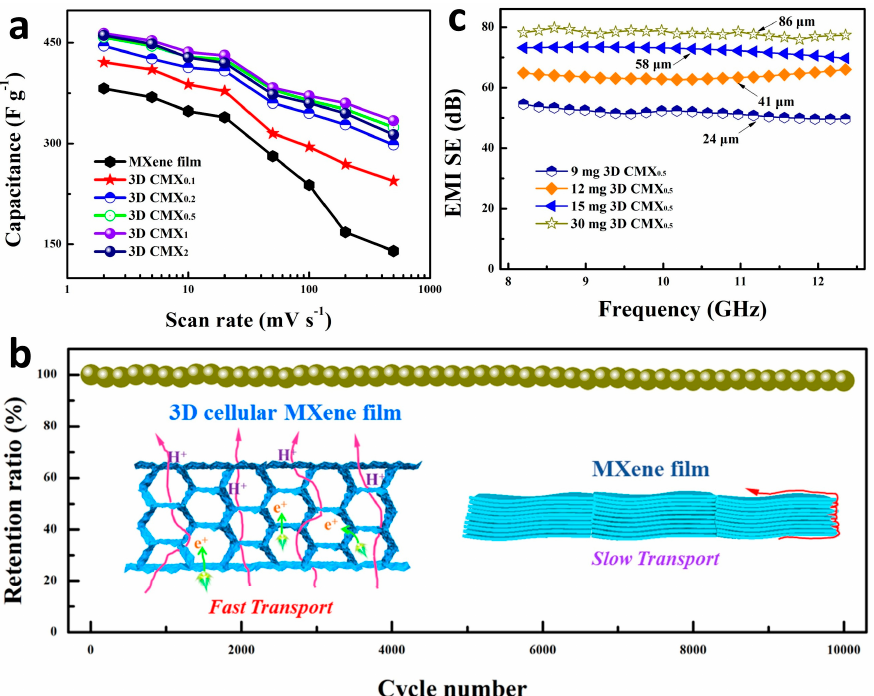
Figure 6. ( a ) Capacitances of 3D cellular MXene film at different scan rates. ( b ) Prolonged cycling performance of 3D cellular MXene film at 100 mV s − 1 . ( c ) EMI SE of the 3D cellular MXene film with different thicknesses; reproduced from [46], with the permission of the American Chemical Society.